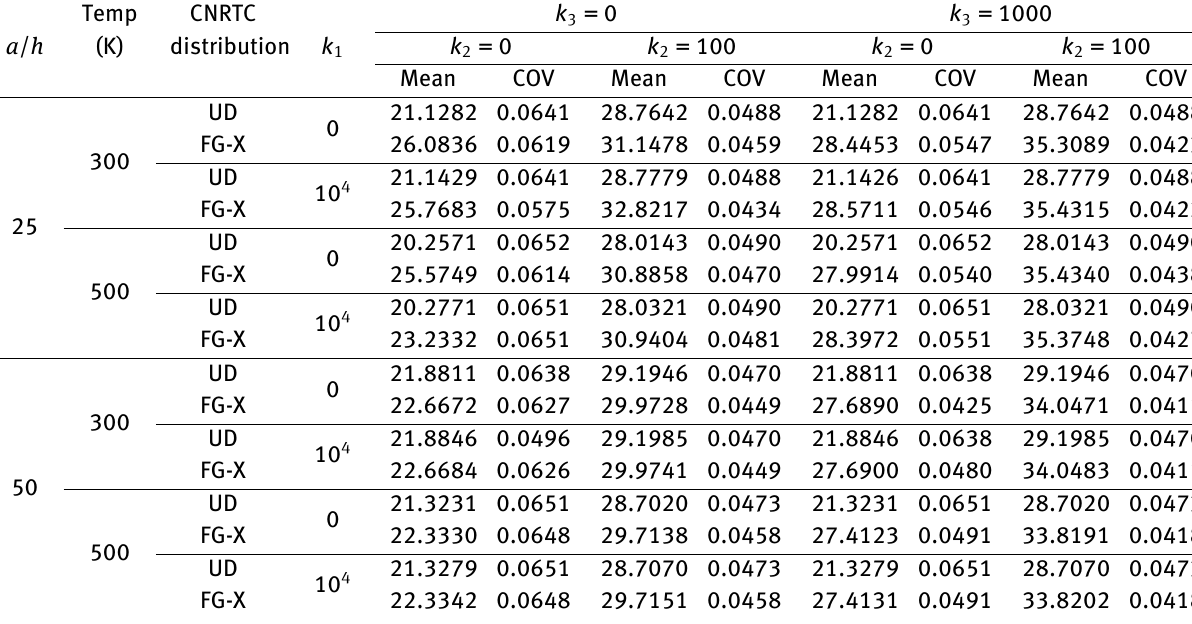
= 0.17 W max / h = 1.0 . cn